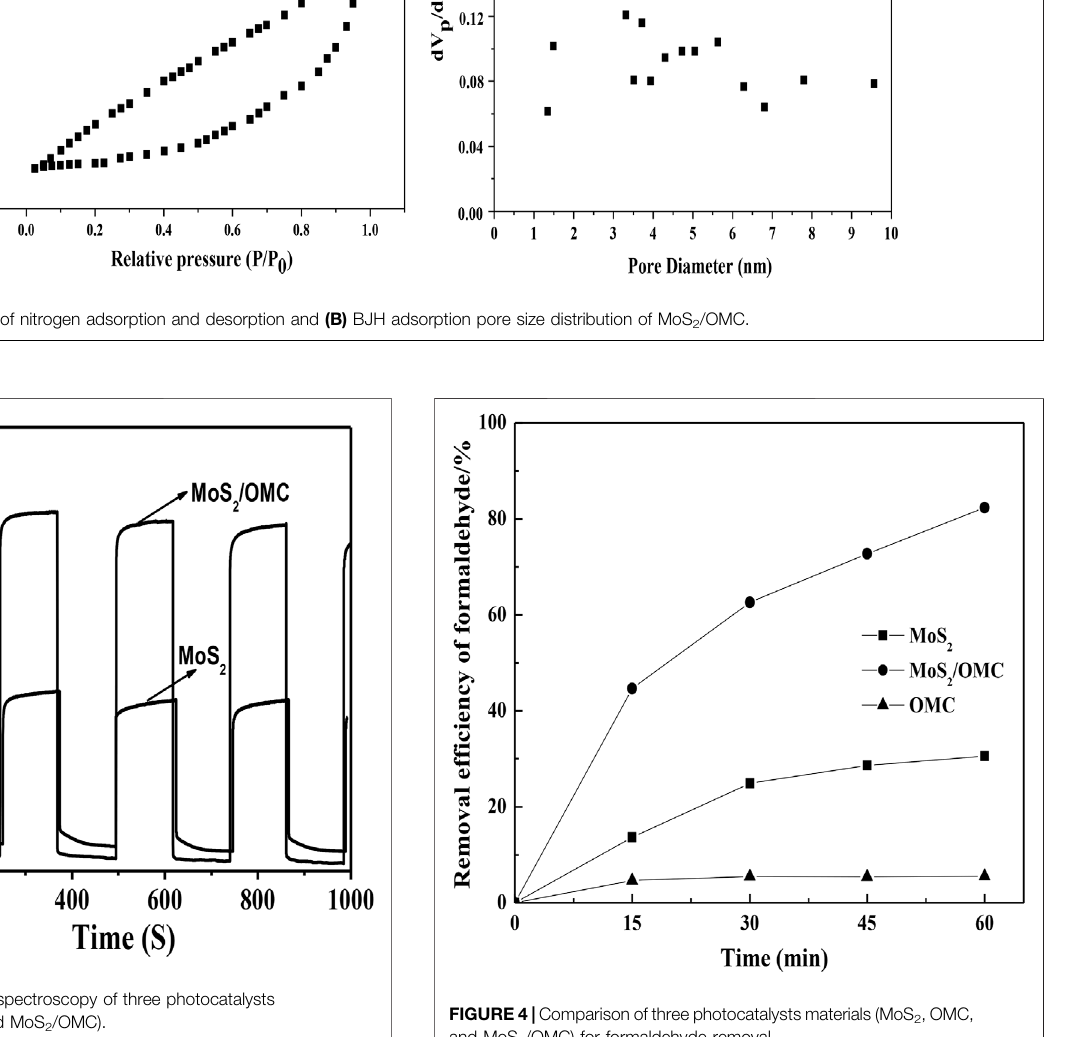
Frontiers in Chemistry |